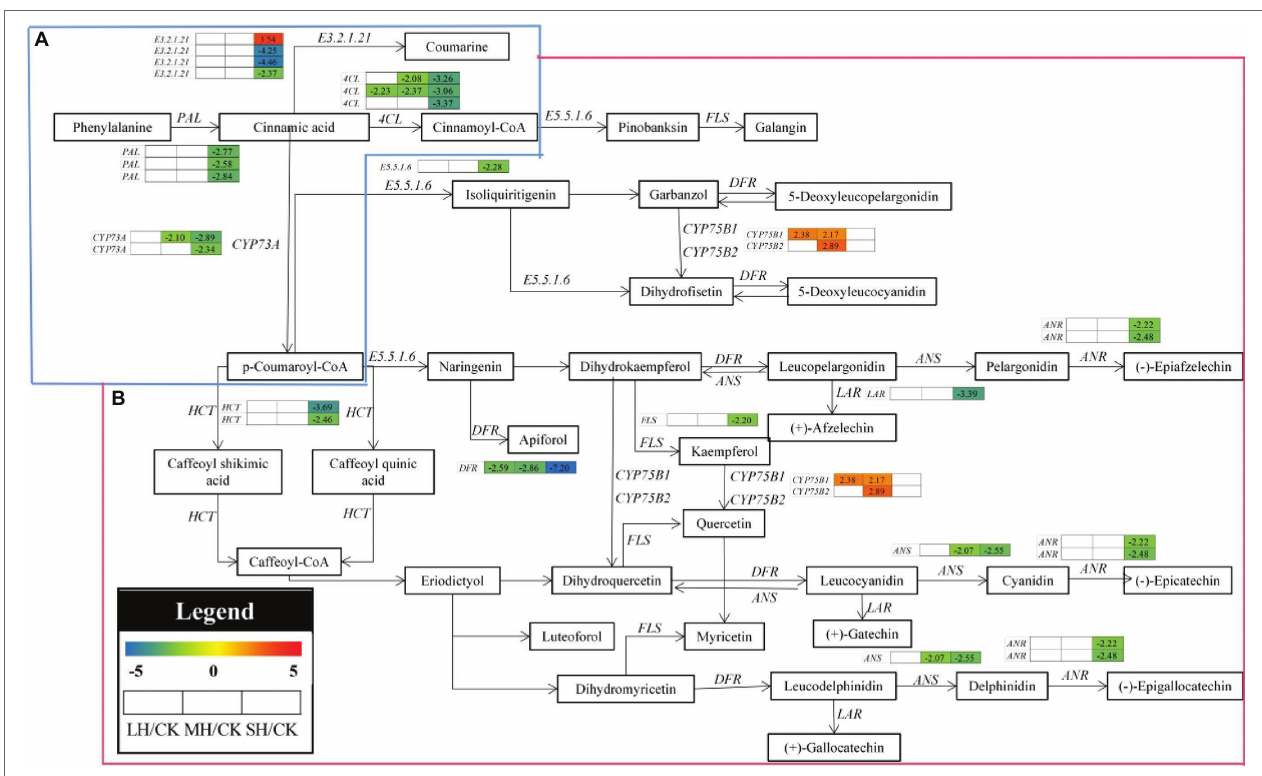
FIGURE 4 | The pathways of phenylpropanoid biosynthesis (A) and flavonoid biosynthesis (B) enriched by Kyoto Encyclopedia of Genes and Genomes (KEGG) analysis. CYP75B1 , flavonoid 3 ′ -monooxygenase; CYP75B2 , flavonoid 4 ′ -monooxygenase; ANS , anthocyanidin synthase; DFR , bifunctional dihydroflavonol 4reductase/flavanone 4-reductase; CYP73A , trans-cinnamate 4-monooxygenase; HCT , shikimate O-hydroxycinnamoyltransferase; LAR , leucoanthocyanidin reductase; FLS , flavonol synthase; ANR , anthocyanidin reductase; E5.5.1.6 , chalcone isomerase; 4CL , 4-coumarate-CoA ligase; E3.2.1.21 , beta-glucosidase; and PAL , phenylalanine ammonia-lyase. The numbers in the gray rectangles indicate the log 2 (fold-changes) of the comparisons. The genes in the picture are all significantly different in the